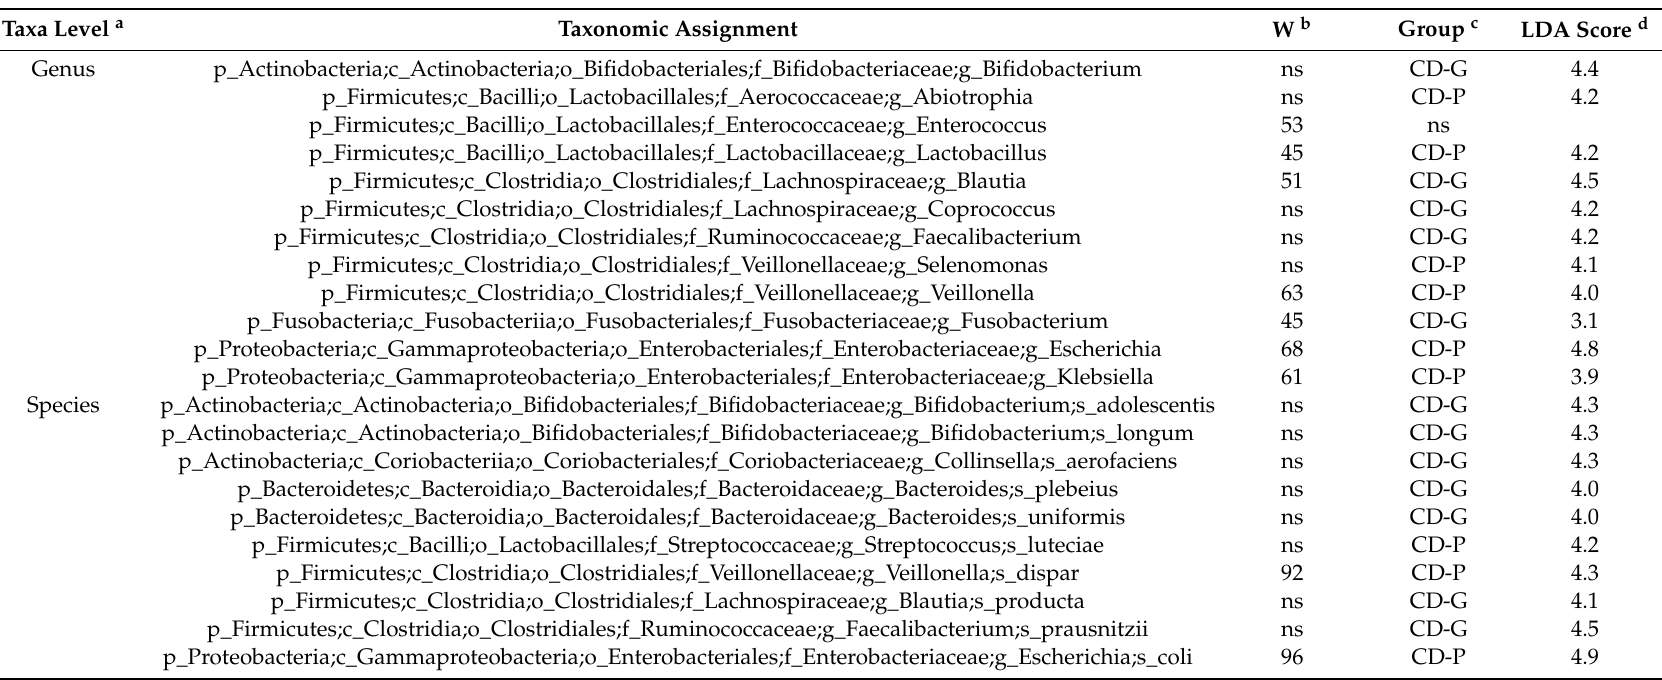
Table 2. Significantly di ff erent taxa between the CD-G and CD-P